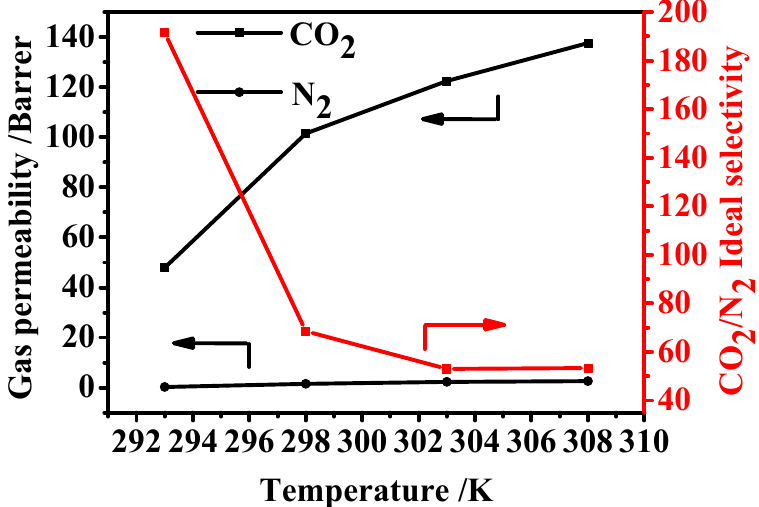
Figure 10. Gas separation performance of PM5 MMM at different testing